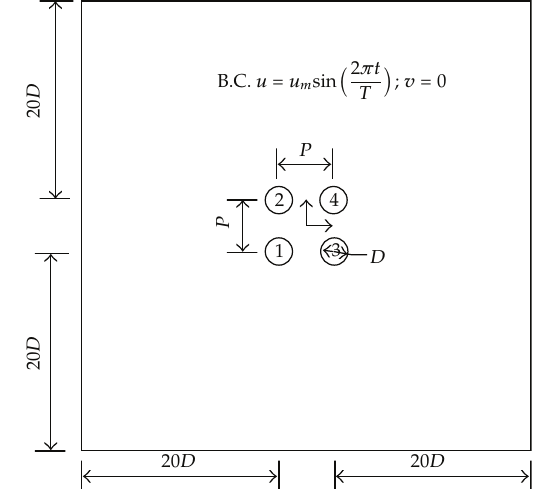
Figure 6: Schematic of interaction of an oscillatory flow with a cylinder array. P/D (cid:8)